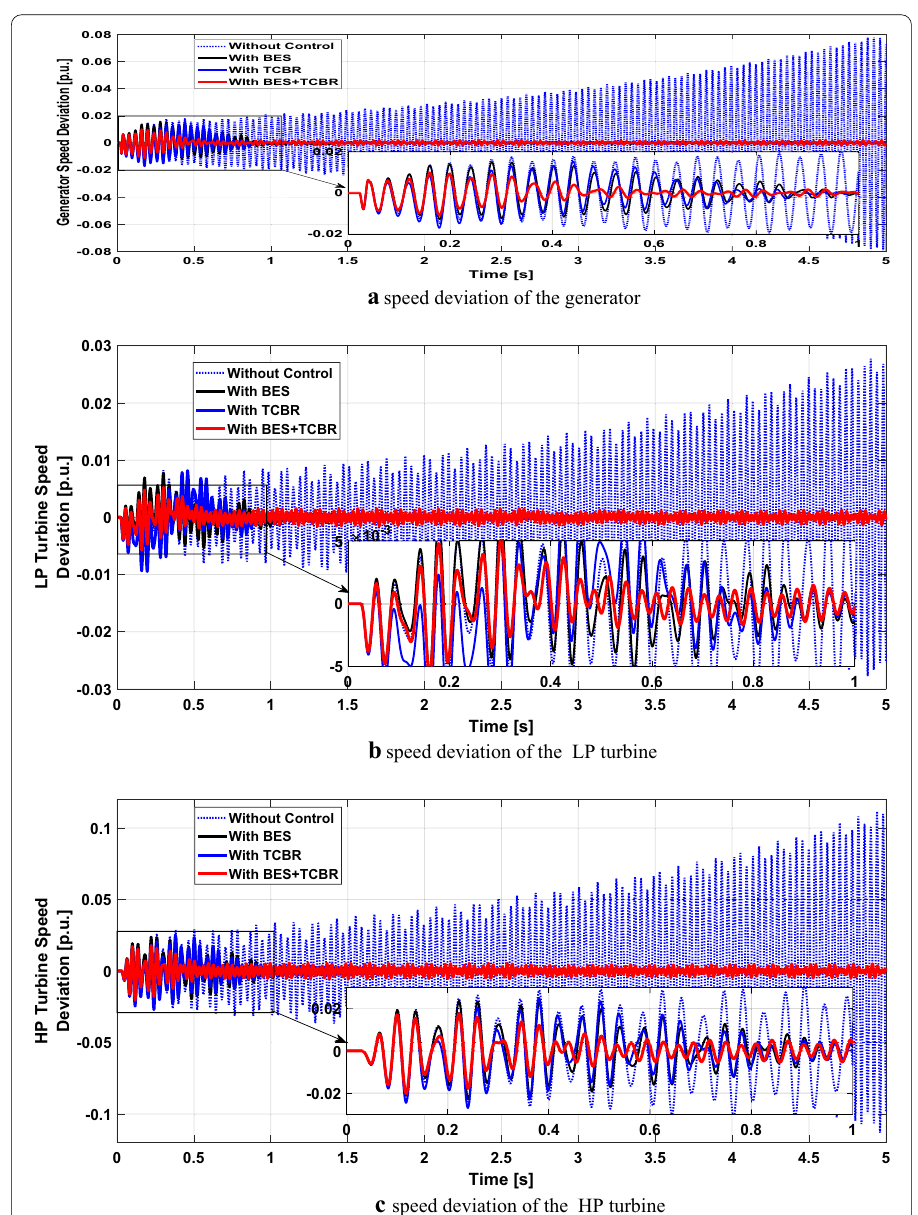
Fig. 8 Speed responses without and with fuzzy controlled BES and TCBR for self‑healing of 3LG fault in